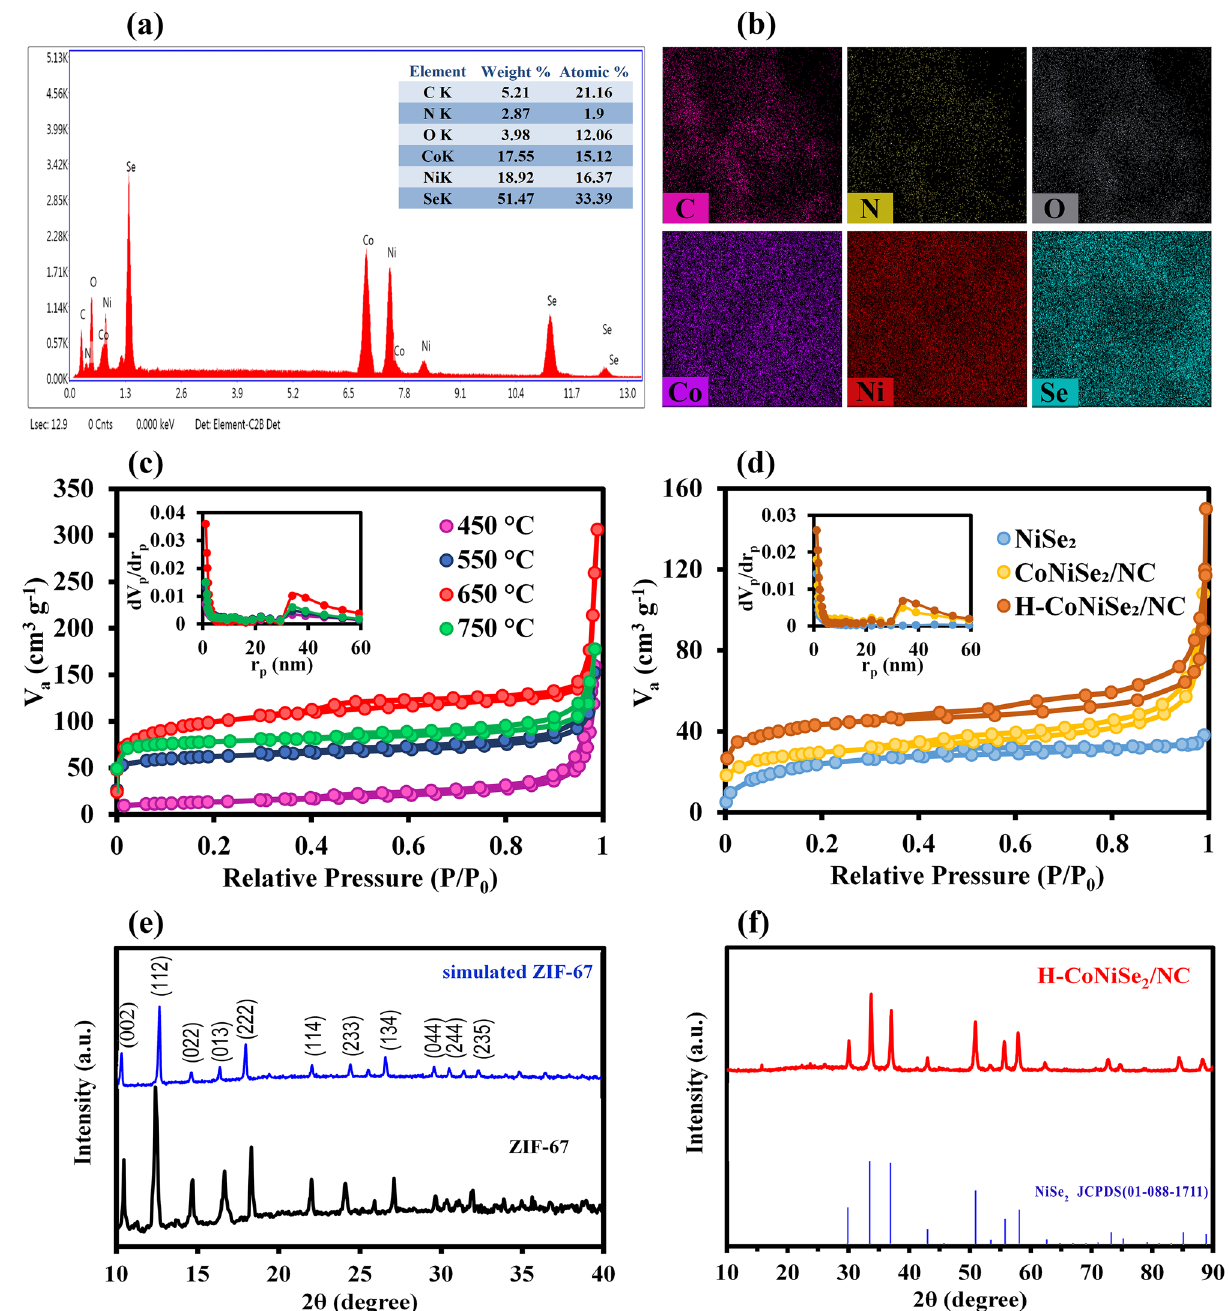
Figure 4. ( a ) EDX spectrum of H-CoNiSe 2 /NC (inset: The weight percentage and atomic percentage analysis of the elements). ( b ) Elemental mapping of C, N, O, Co, Ni, and Se. BET surface area and pore size distribution of ( c ) Co/NC at different temperatures and ( d ) H-CoNiSe 2 /NC, CoNiSe 2 /NC, and NiSe 2 . XRD patterns of ( e ) ZIF-67 and ( f ) H-CoNiSe 2